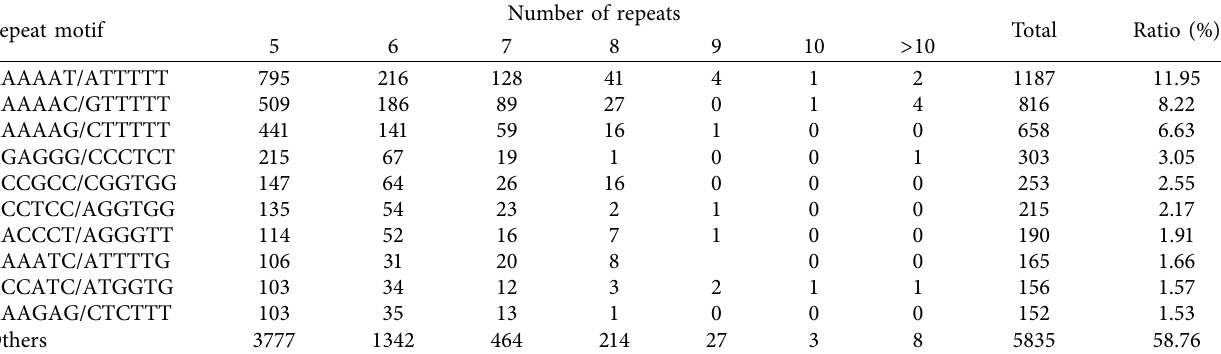
Table 9: Statistics of hexanucleotide 9, 930